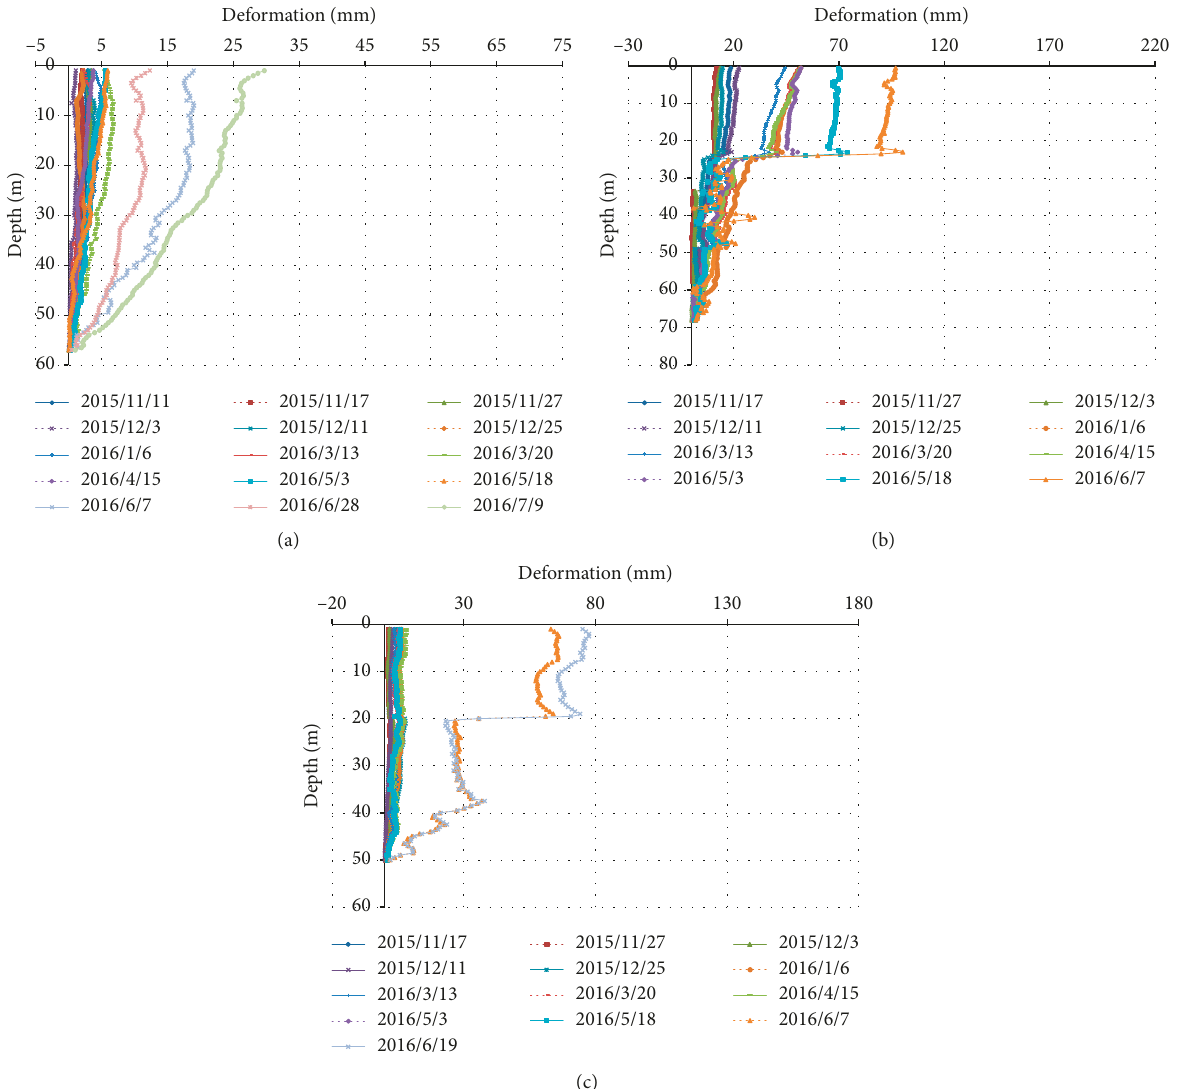
Figure 4: Cumulative displacement curve at different elevations for the inclination survey of CJQ-3-3 section. (a) Elevation 1,710m. (b) Elevation 1,660m. (c) Elevation